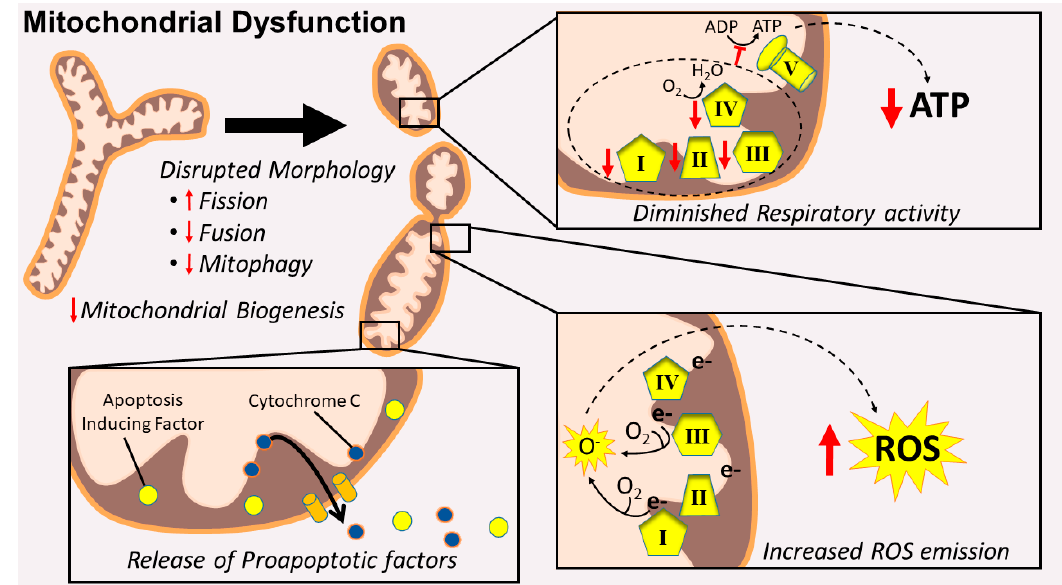
Figure 1. Dysfunctional mitochondria display a disrupted morphology that appears swollen and fragmented compared to healthy mitochondria. These alterations coincide with an impaired respiratory capacity (e.g., decreased mitochondrial complex activity) that results in diminished ATP production, increased mitochondrial ROS emissions, and the release of mitochondria-derived proapoptotic